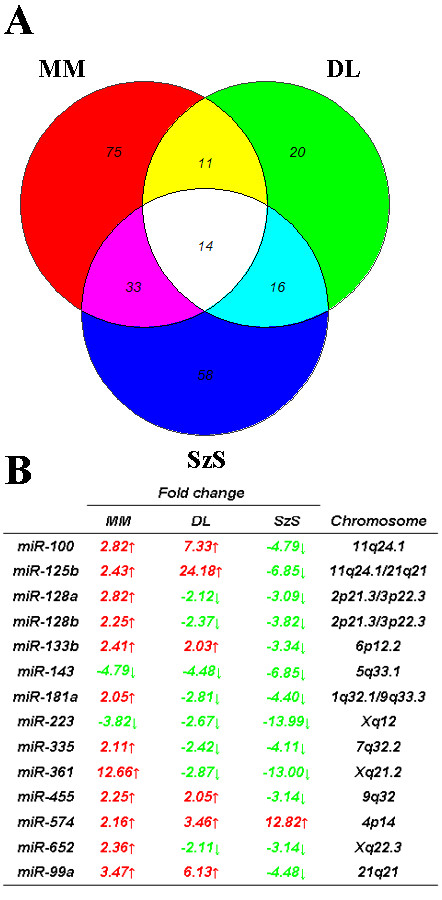
MicroRNAs commonly dysfunctionally expressed in multiple lymphoma types. (A) Venn diagram showing relationship between microRNAs aberrantly expressed in diffuse large B-cell lymphoma (DLBCL) [7], Sezary syndrome (SzS) [10] and multiple myeloma (MM) ((Table 1) (Additional file 1, Table S2)). (B) Tables of microRNAs aberrantly expressed in all lymphoma types depicting fold change relative to normal counterpart controls.